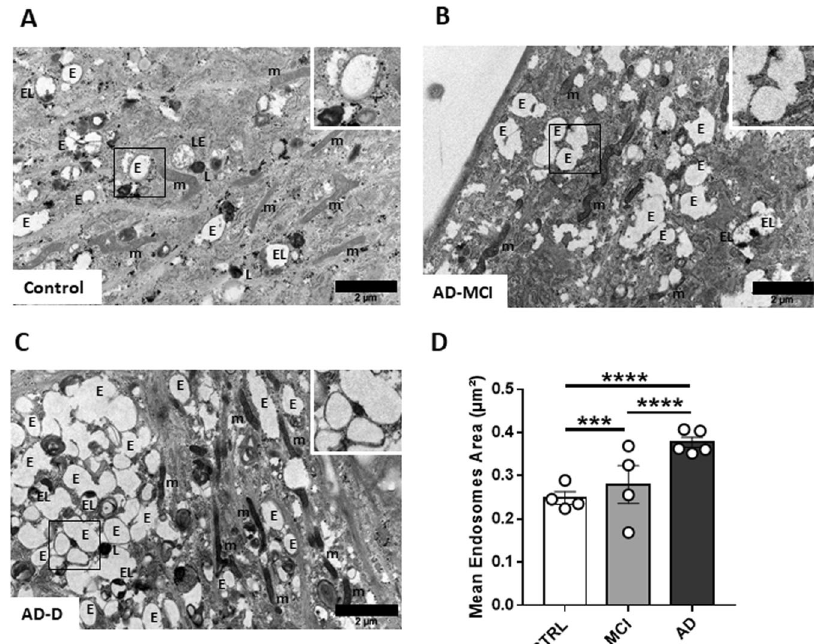
Fig. 3 Ultrastructural imaging of the endosomal compartment in fi broblasts of controls. A AD-MCI ( B ) and AD-D ( C ). The squared zones are magni fi ed at the upper right of each image. D Analysis of the mean endosome area (µm 2 ) on at least 20 different fi elds (>200 endosomes) obtained from controls ( n = 3), AD-MCI ( n = 4) and AD-D ( n = 4). m mitochondria, L Lysosome, E Endosome, EL Endolysosome, and LE Late Endosome.